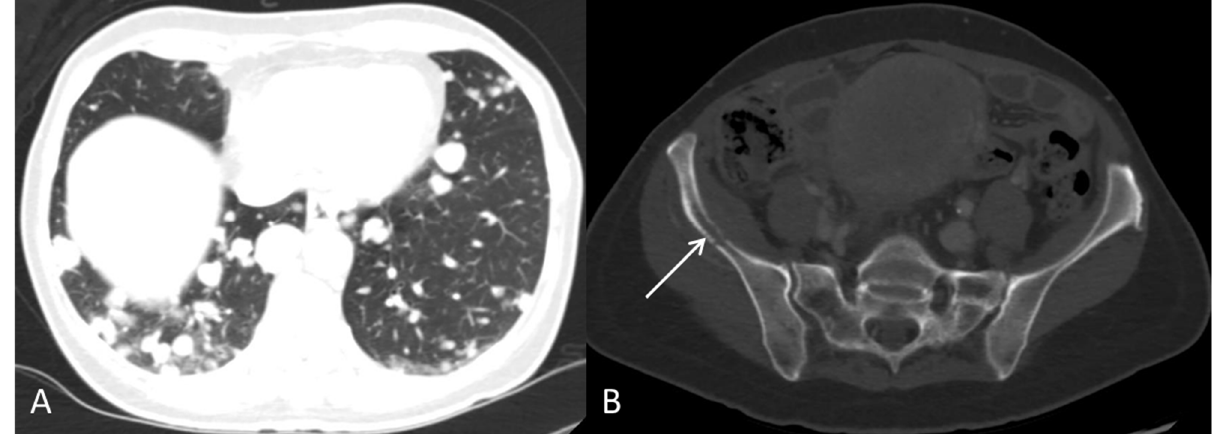
Figure 8. The contrast-enhanced CT, after approximately two months of sorafenib treatment, showed